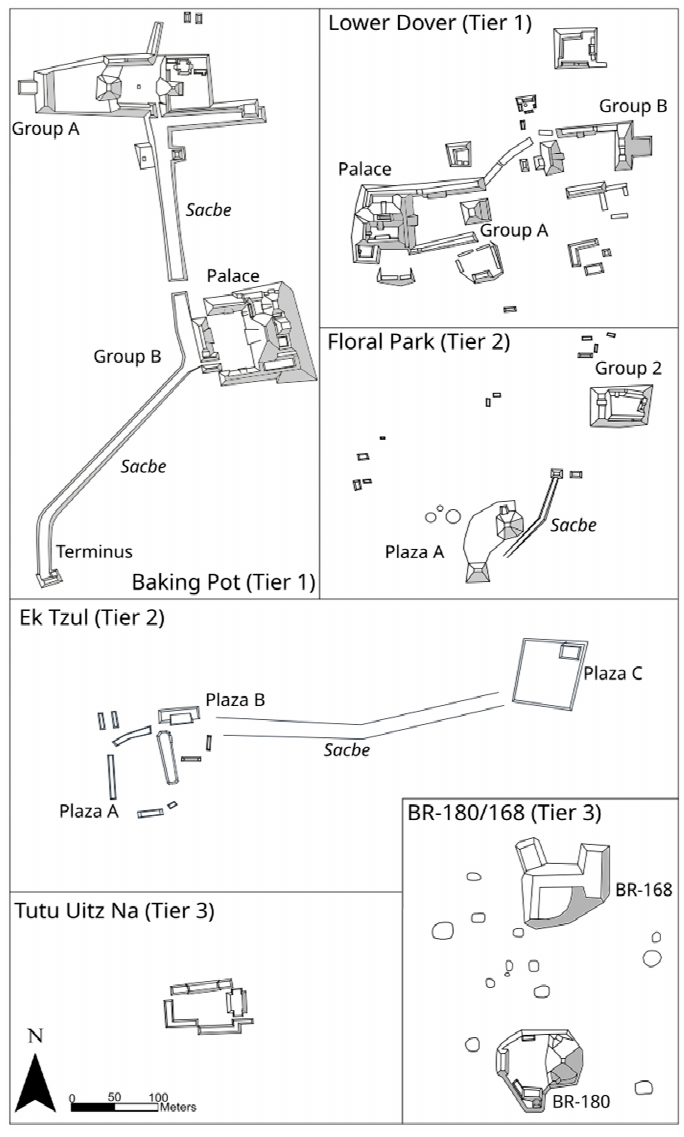
Figure 2. Maps of major and minor centers in the Baking Pot and Lower Dover polities showing different structure types, adapted from [1,26,97–101]. (Figures 143, 177 and 179; Figures 6.18, 6.96 and 6.124; Figure 4.1; Figure 1; Figure 2; Figure 1; Figure